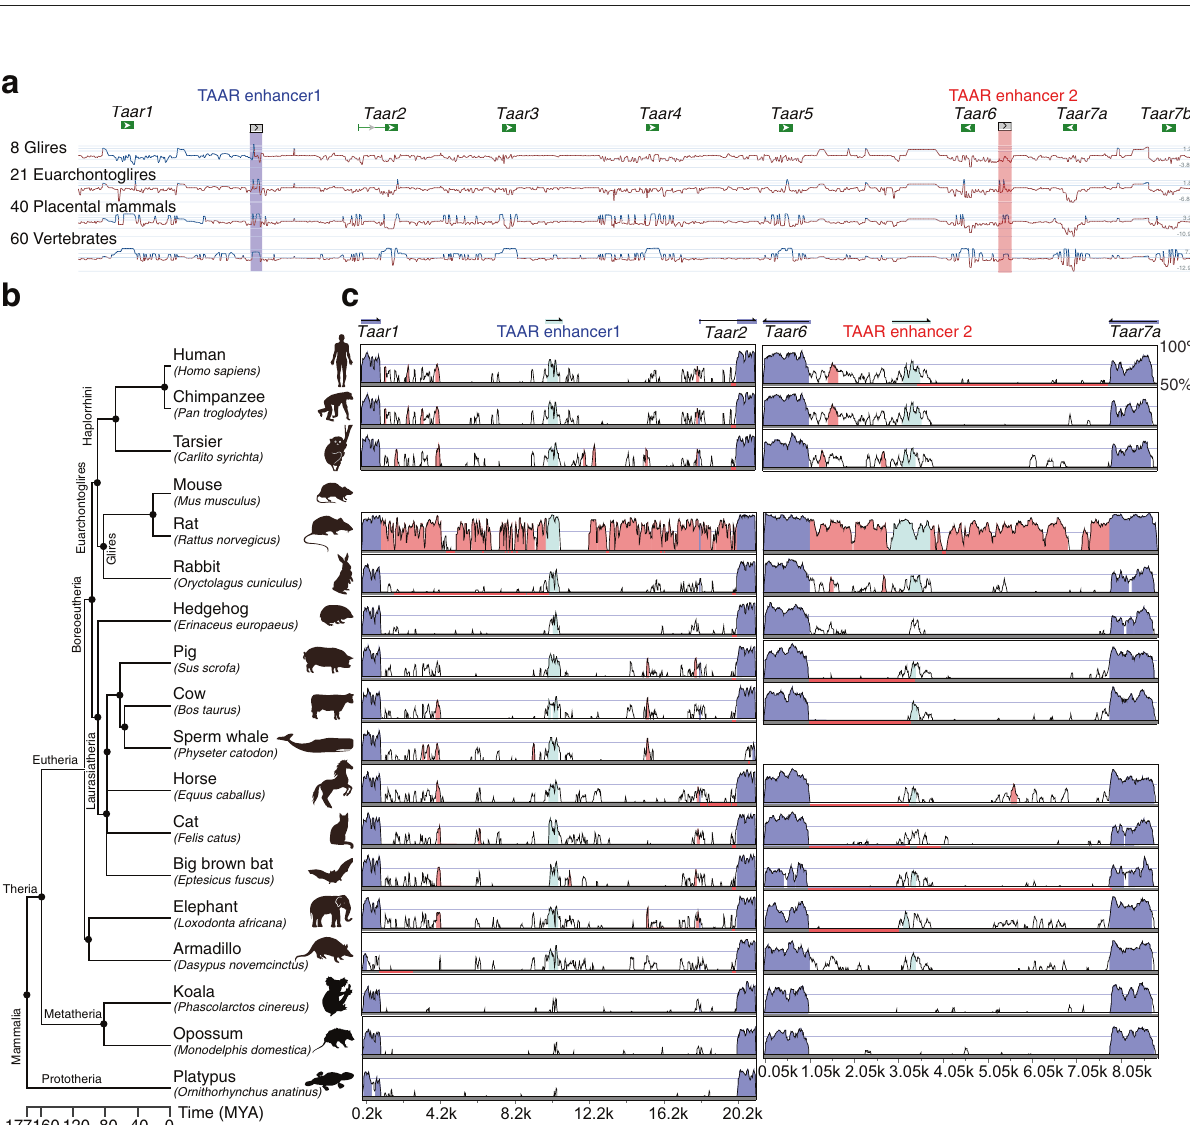
Fig. 2 Identi fi cation of two putative TAAR enhancers. a Schematic illustration of the strategy to identify putative TAAR enhancers using ATAC-seq. b 6093 differential peaks with 3290 peaks enriched in OMP-positive OSNs and 2803 peaks enriched in TAAR OSNs were identi fi ed with criterion of q < 0.05. c ATAC-seq signals across the Taar cluster showed two putative TAAR enhancers that were enriched in TAAR OSNs. ATAC-seq signals were normalized to median peak values of each sample. Below the signal tracks, exons of the Taar genes were depicted. Arrows inside exons indicate direction of sense strand. Shaded regions indicate ATAC-seq peaks called by MACS2. d ATAC-seq peak intensities of two TAAR enhancers in OMP-positive OSNs and TAAR OSNs were normalized to median peak values and plotted. e ATAC-seq signals of Rhodes, an OR enhancer, showed similar chromatin accessibility in OMP-positive OSNs and TAAR OSNs. ATAC-seq signals were normalized to median peak values of each sample. Below the signal tracks, exons of two surrounding OR genes were depicted. Arrows inside exons indicate direction of sense strand. Shaded regions indicate ATAC-seq peaks called by MACS2. f Correlation between normalized ATAC-seq peak intensities of all 63 OR enhancers in TAAR OSNs ( Y -axis) and those in OMP-positive OSNs ( X -axis). Pearson correlation coef fi cient r = 0.89 (two-sided, no adjustments were made), p < 0.0001. In d , *** q < 0.001, by the Wald test (two-sided). In d , f , n = 3 for OMP-positive OSNs, n = 6 for TAAR OSNs. In d , data are presented as mean values ± SEM.